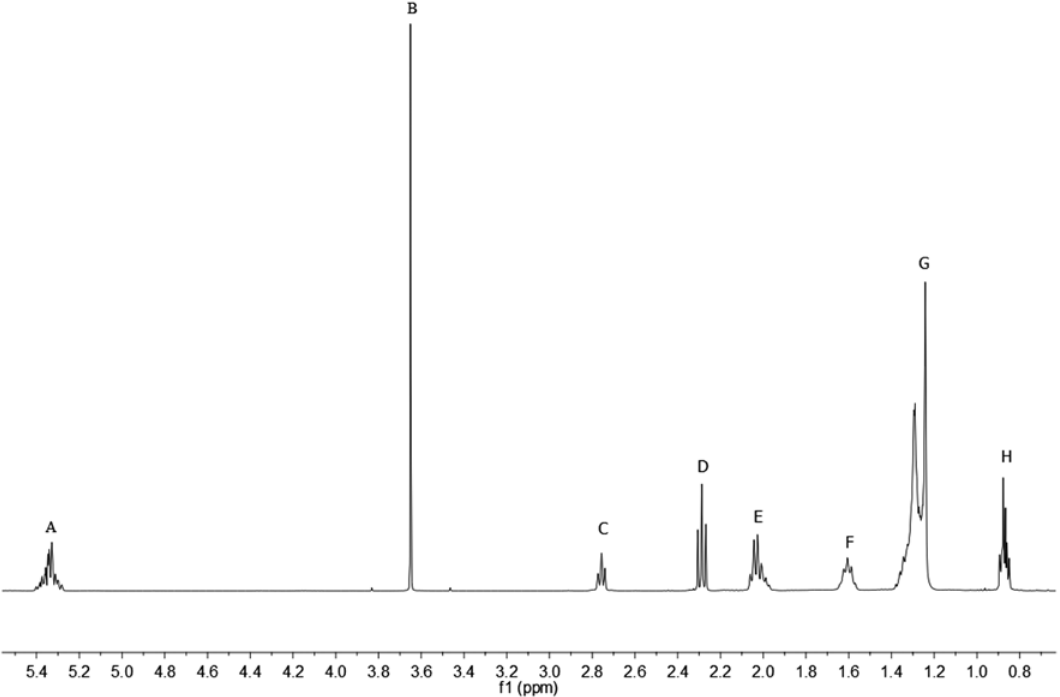
Figure 7: Proton nuclear magnetic resonance ( 1 H-NMR) spectrum of biodiesel sample obtained from cotton oil using calcium oxide. (A) 5.37–5.31 ppm: HC = CH; (B) 3.61 ppm: CH -O; (C) 2.77–2.74 ppm: C = C-CH -C = C; (D) 2.31–2.27 ppm: CH -C = O; (E) 2.06–1.99 ppm: CH 3 2 2 (F) 1.62–1.59 ppm: CH -C-C = O; (G) 1.30–1.24 ppm: -CH -; (H) 0.89–0.85 ppm: CH 2 2 3